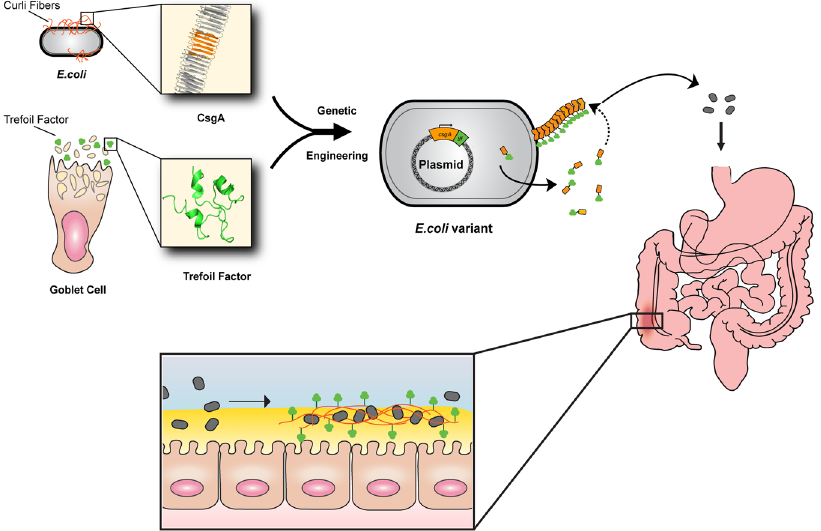
Figure 1. Repurposing commensal E. coli curli fiber proteins through TFF display ( A ). Schematic overview of reprogrammed E. coli curli nanofibers. CsgA, the main proteinaceous component of E. coli biofilm matrix, assembles into extracellular amyloid fibers after secretion in the monomeric form (top, inset shows one CsgA monomer highlighted in orange). Trefoil factors, like TFF3 (PDB ID: 1PE3, green), are cytokines secreted by mucus producing cells., E. coli was engineered to display the trefoil factors as genetic fusions to the C-terminus of CsgA. CsgA-TFF chimeras are self-assembled into nanofibers extracellularly ( B ), where they can modulate interactions with mucosal epithelium tissues ( C